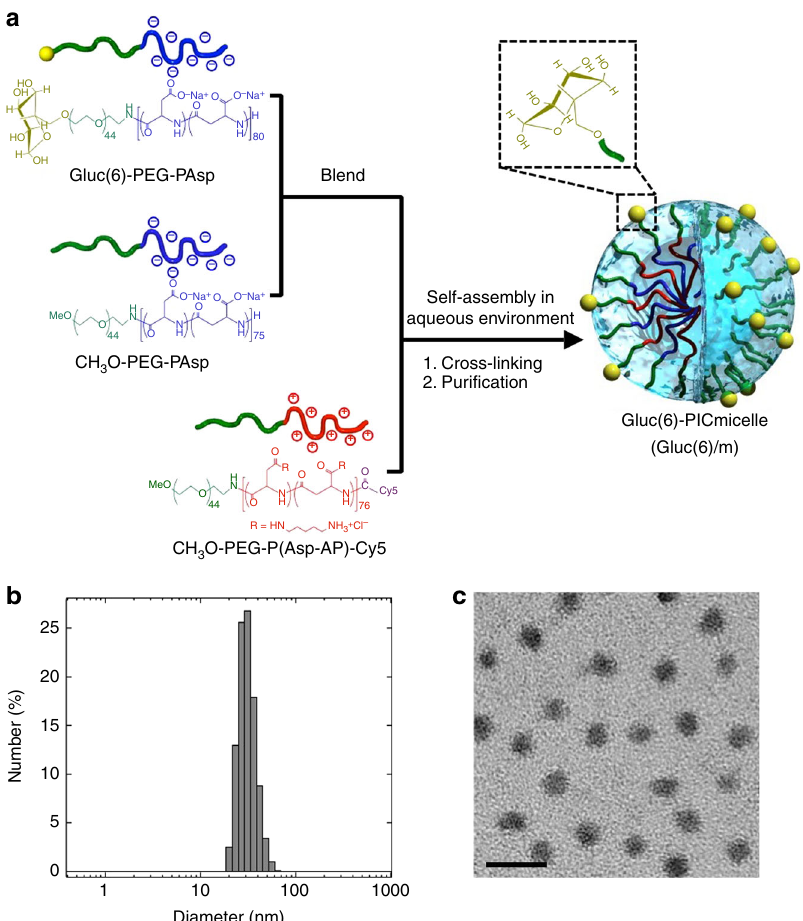
Fig. 1 Characterization of the Gluc(6)-conjugated PIC micelle (Gluc(6)/m). a Scheme of Gluc(6)/m preparation via the assembly of oppositely charged block copolymers. b Size distribution of the 25%Gluc(6)/m determined by DLS. c TEM image of the 25%Gluc(6)/m. The scale bar indicates 50